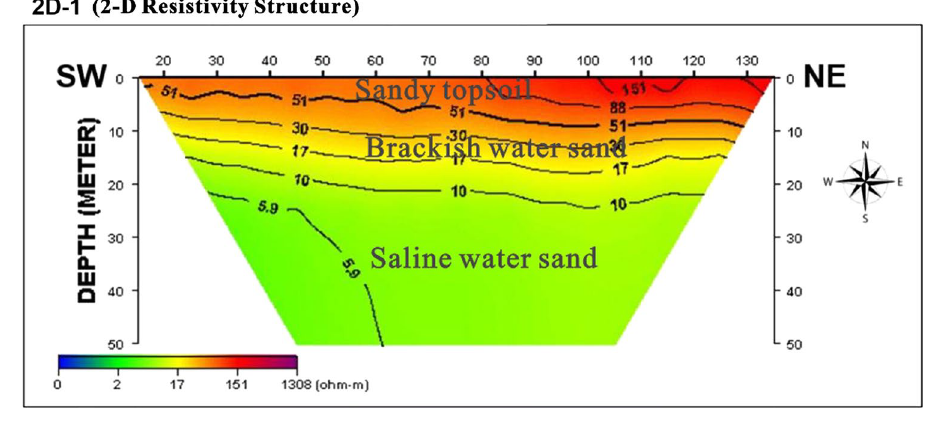
Fig. 5 Resistivity imaging of Traverse 2D-1